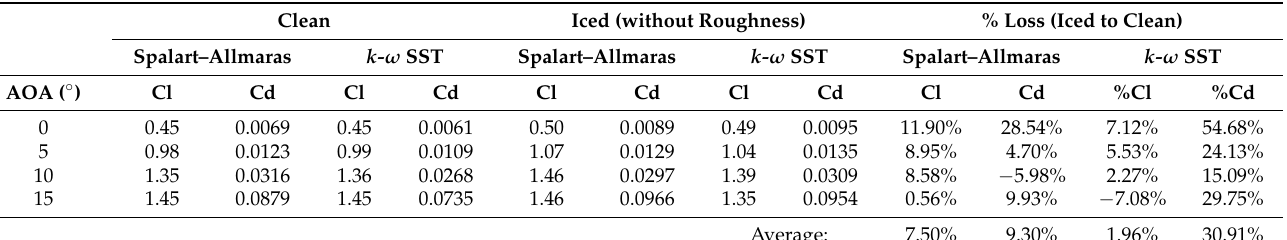
Table 6. Aerodynamic loss estimated without roughness consideration.